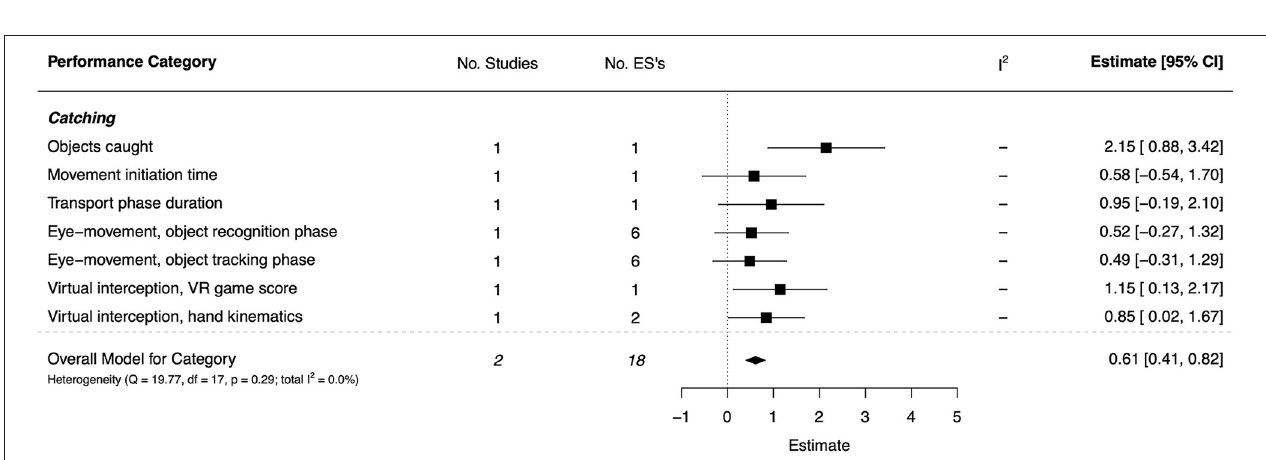
FIGURE 9 | Forest plot showing the meta-analysis results for the internal modeling (incl. prospective reaching/grasping) performance category. VM, Visuomotor.